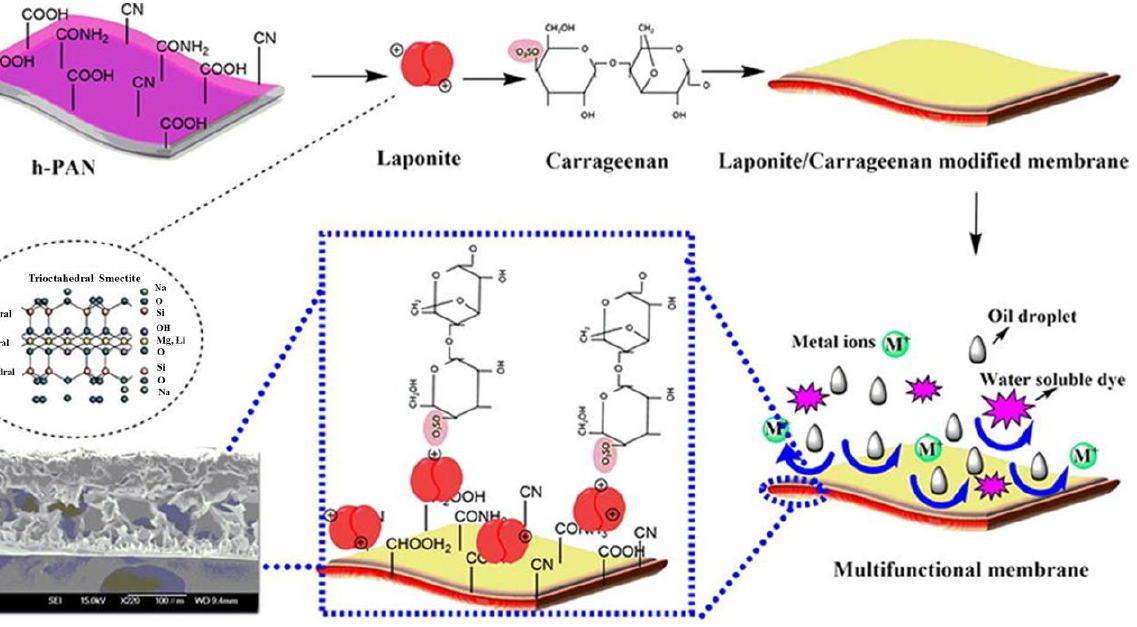
Figure 7. Preparation of the ĸ -carrageenan/laponite coating of h-PAN membranes with multifunc- tional properties. Reproduced with permission from Chemical Engineering Journal; published by Elsevier, 2020 [121].